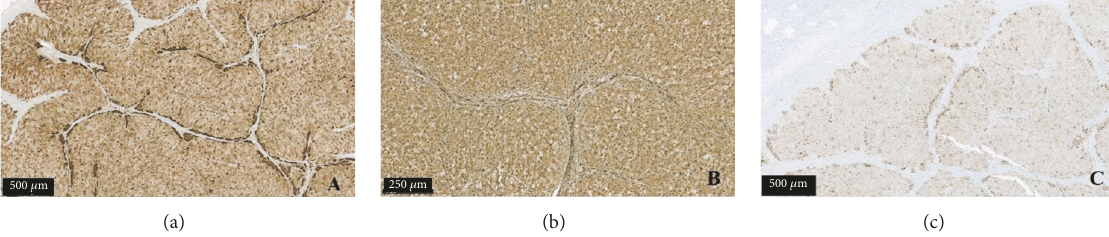
Figure 2: Immunohistochemical staining. Marking (a) for calretinin; (b) for vimentin; and (c) for